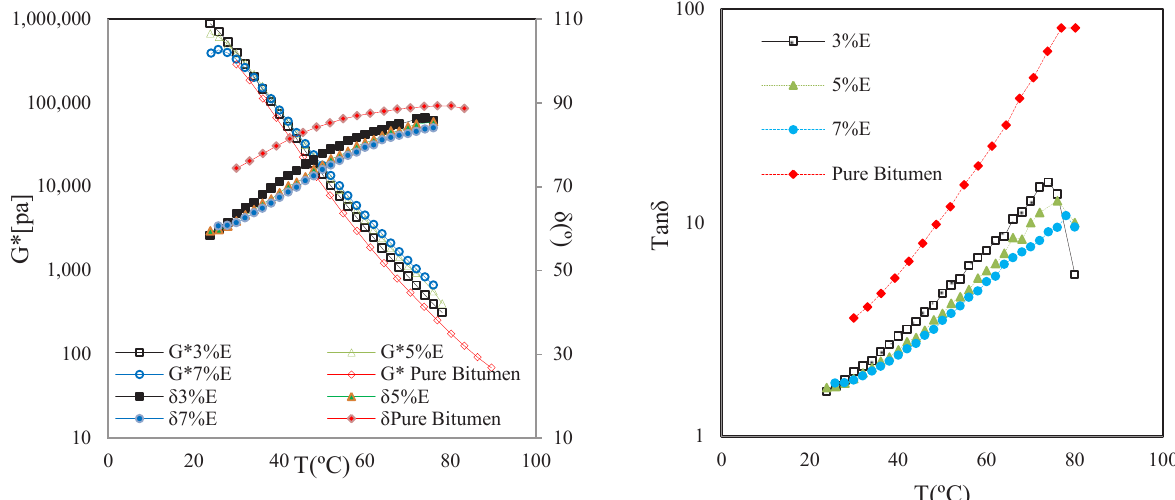
Fig. 5. Complex modulus/phase angle (left) and Tanδ (right) curves for the bitumen modified by blend E.